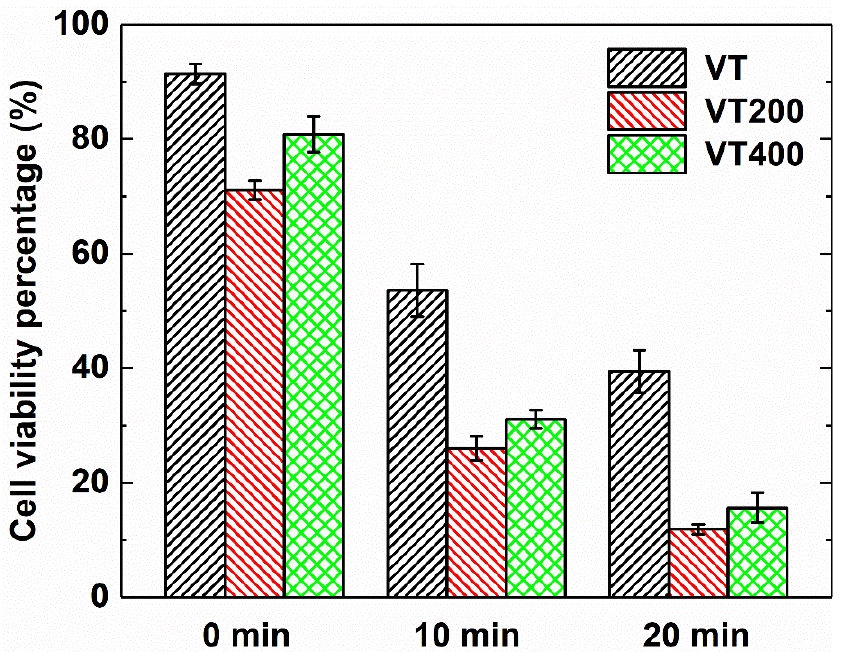
Figure 7. Cell viability percentage of MG-63 cells at different times after photothermal treatment on VT, VT200, and VT400 coating surfaces at 0.5 W/cm 2 .